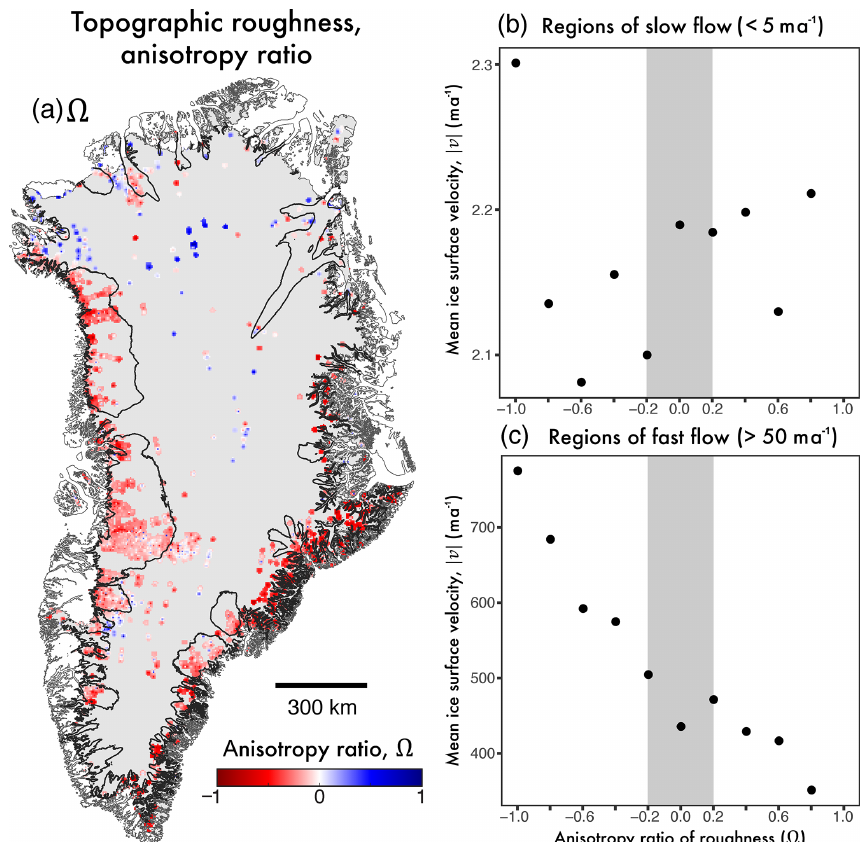
Figure 8. Calculated anisotropy ratio for R . (a) Anisotropy ratio, (cid:127) , where values of − 1 dictate a dominance of smoothness parallel to flow direction, values of + 1 indicate a dominance of smoothness perpendicular to flow (i.e., parallel roughness), and values of 0 indicate isotropy. (b) and (c) present mean ice surface speed, | v | , calculated for anisotropy ratio bins (at 0.1 intervals) for slow- and fast-flowing regions,